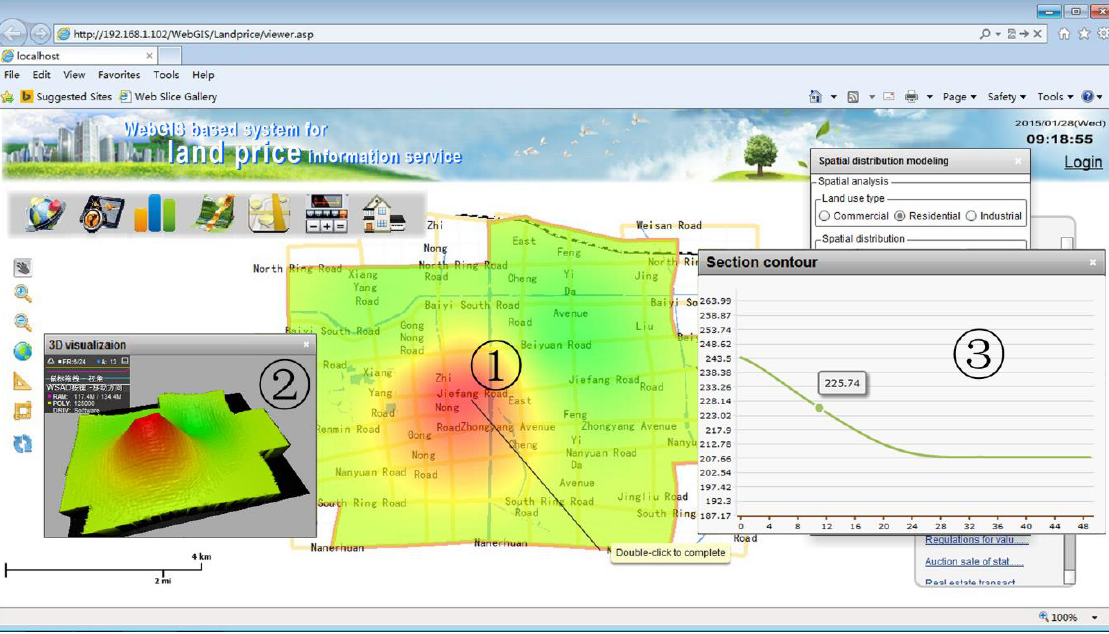
Figure 5. Spatial distribution modeling of land